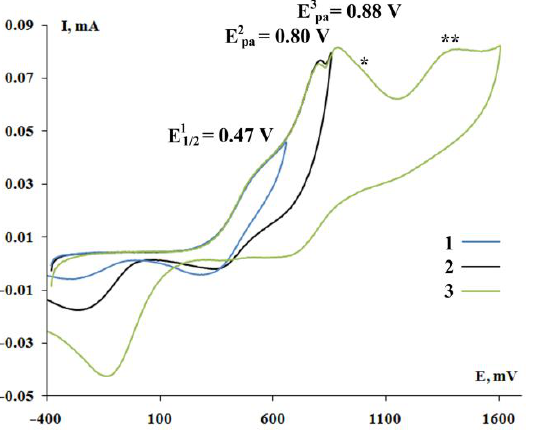
Figure 14. The CV of complex [(3,5-DBCat)SbPh 3 ] 2 · DABCO ( 9 ) at the potential sweep from − 0.4 to 0.65 V (curve 1); from − 0.4 to 0.85 V (curve 2); from − 0.4 to 1.6 V (curve 3) (CH 2 Cl 2 , GC, C = 3 × 10 − 3 M, 0.1 M Bu 4 NClO 4 , Ag/AgCl/KCl(sat.)). * and **—the oxidation peaks of mononuclear (3,5-DBCat)SbPh 3 (E 1 1/2 = 0.91 V, E 2 p = 1.40 V vs. Ag/AgCl/KCl(sat.)).